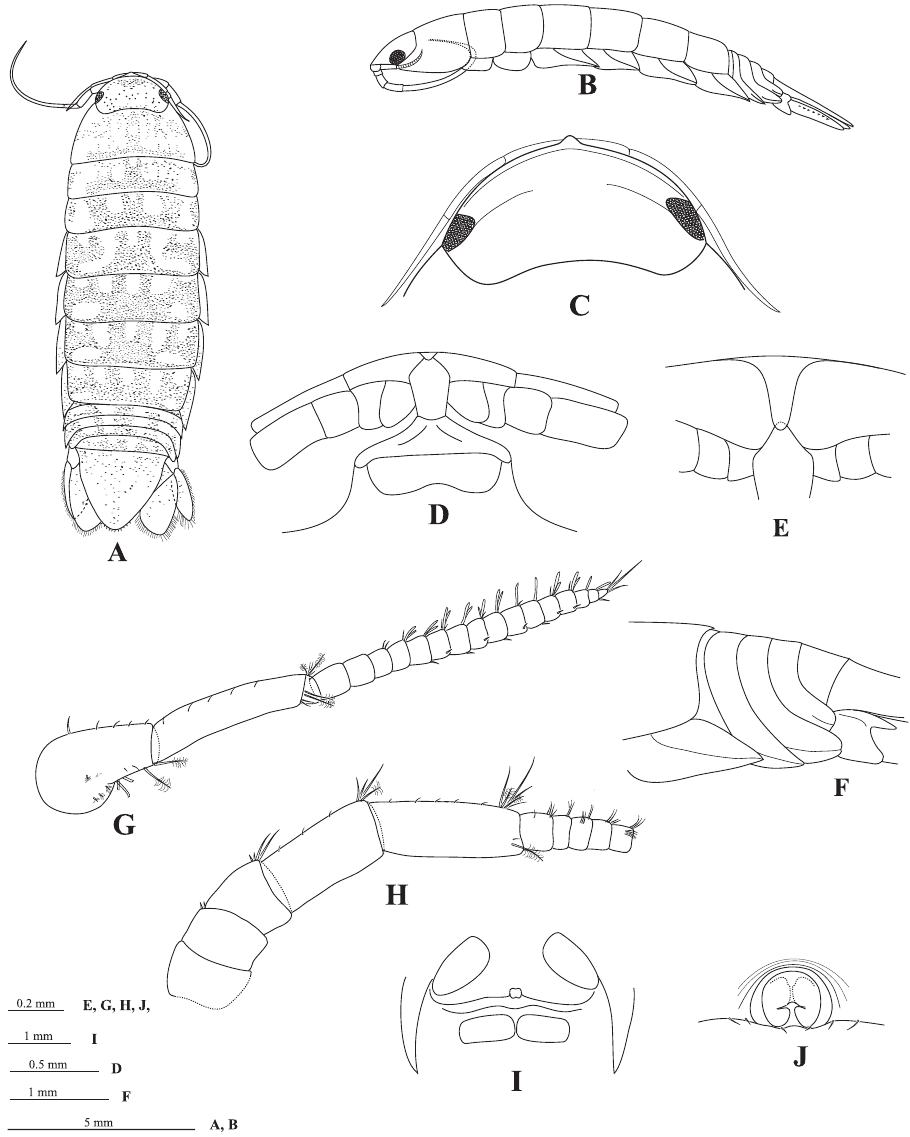
Figure 2. Cirolana songkhla sp. n., male holotype (PSUZC-CR0281-01) (13.7 mm) ( A–F ), male para- type (PSUZC-CR0281-2) (11.2 mm) ( G–h ), male paratype (PSUZC-CR0281-2) (13.8 mm) ( I–J ). A dorsal view B lateral view C head, dorsal view D frons e detail of frontal lamina F pleon G antennule h antennal peduncle I antero-ventral view of penial opening J ventral view of penial Antennule (Figure 2G) peduncle articles 1 and 2 entirely fused; articles 3 and 4 1.3 times as long as combined lengths of articles 1 and 2, article 3 5.0 times as long as wide; flagellum with 16 articles, extending to middle of pereonite 1. Antenna